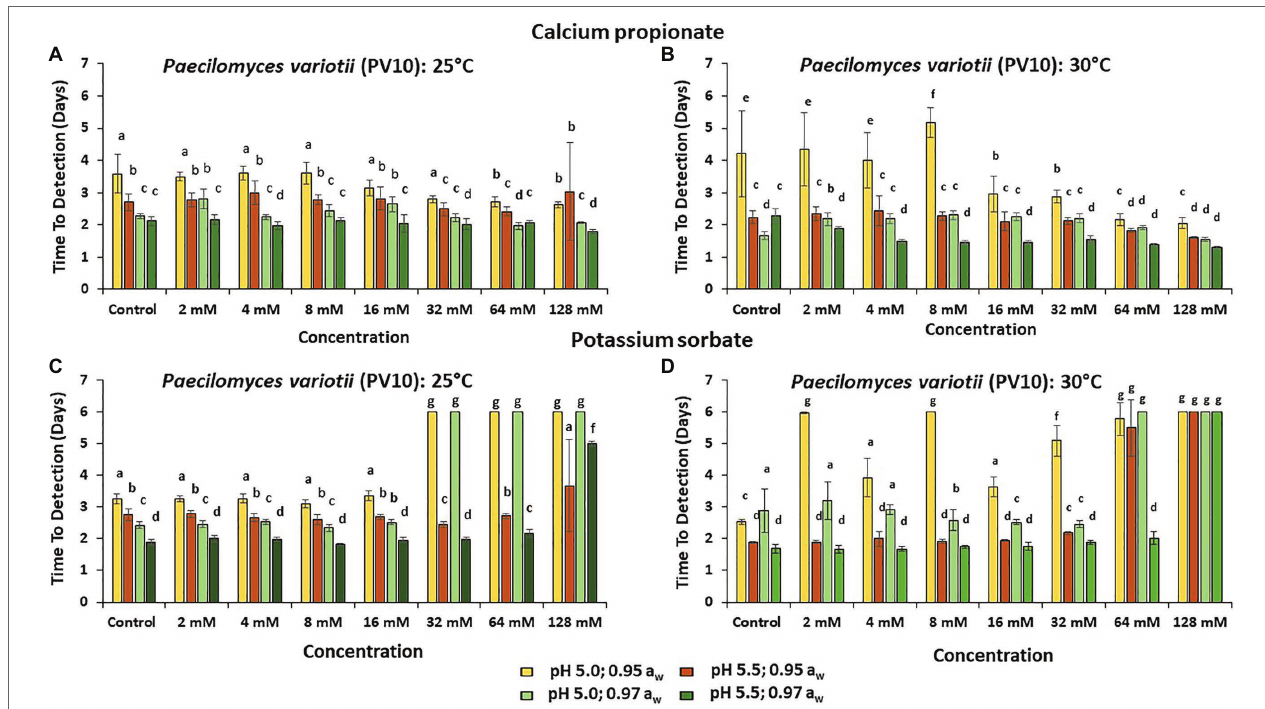
FIGURE 4 | The TTD (OD = 0.4 OD; 6 days) of P. variotii (PV10) at (A) 25 ° C and (B) at 30 ° C in the presence of different concentrations of CP; and for PS at (C) 25 ° C and (D) 30 ° C. Bars represent the SEM. Treatments with different letters are significant ( p = 0.05).